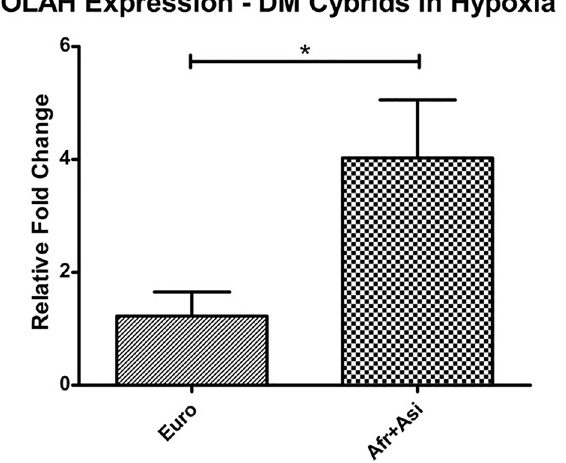
Figure 1. [Afr + Asi]/DM cybrids express more OLAH transcript in hypoxia than similarly-treated Euro/DM cybrids. RNA from DM cybrids cultured 48 h in 2% O 2 was analyzed by qRT-PCR to measure transcript levels of the Oleoyl-ACP Hydrolase ( OLAH ) gene and compare expression between Euro/DM and [Afr + Asi]/DM cybrids. The data were normalized to average OLAH expression in Euro/DM cybrids (Fold-Change = 1).